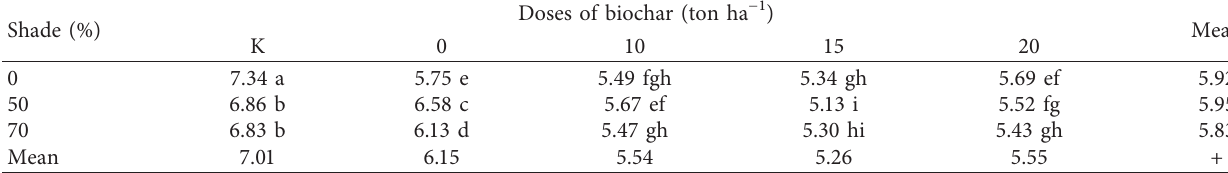
Table 3: Effects of biochar and shade application on the soil